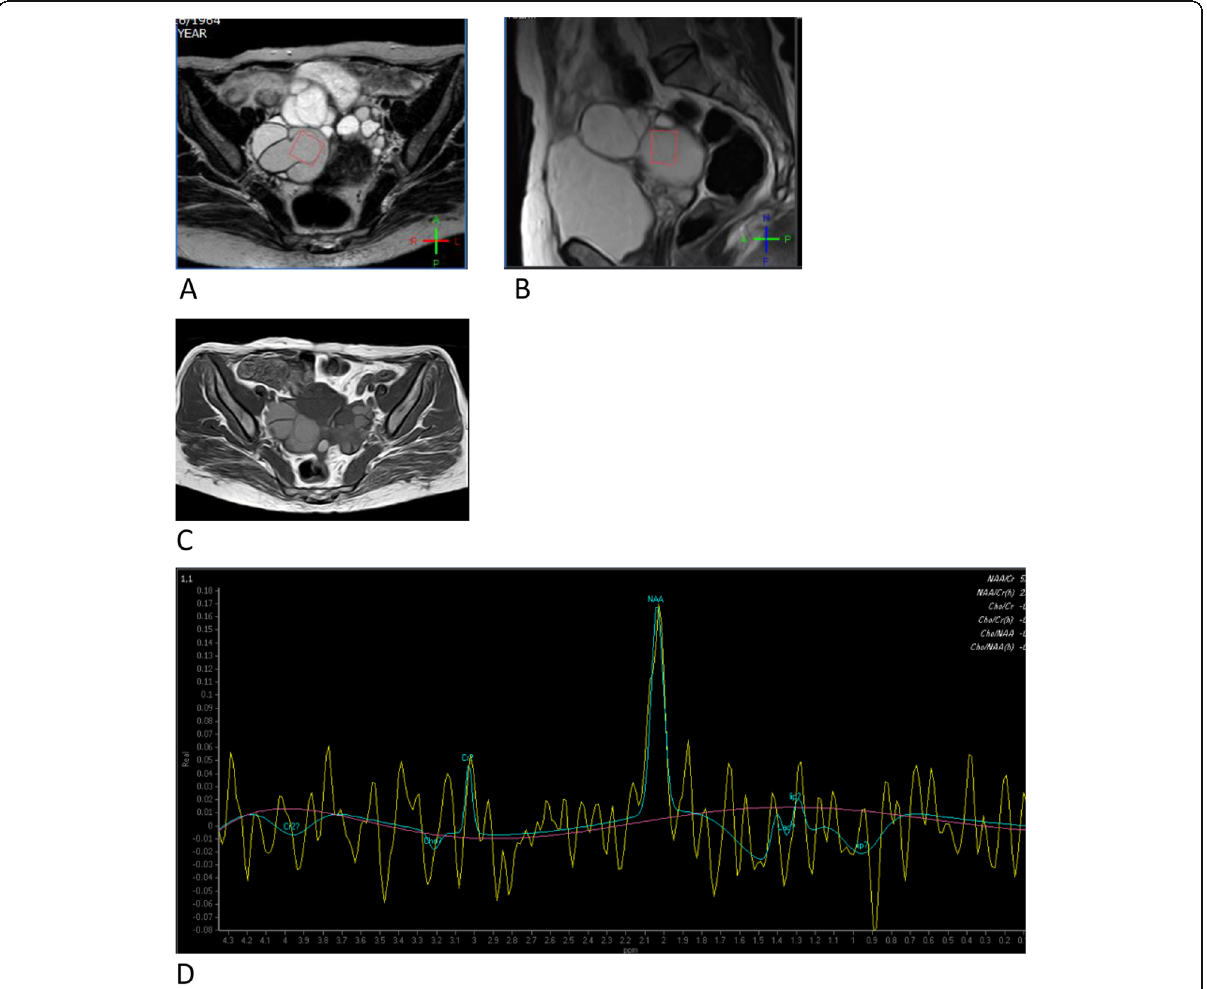
Fig. 6 A 53-year-old woman with past history of breast cancer, with pathologically proven bilateral mucinous cystadenomas. a , b Axial and sagittal T2-weighted images showing bilateral multicystic ovarian masses with voxel in the center. c Axial T1-weighted image shows bilateral high signal ovarian masses. d MR spectroscopy shows sharp NAA peak at about 2